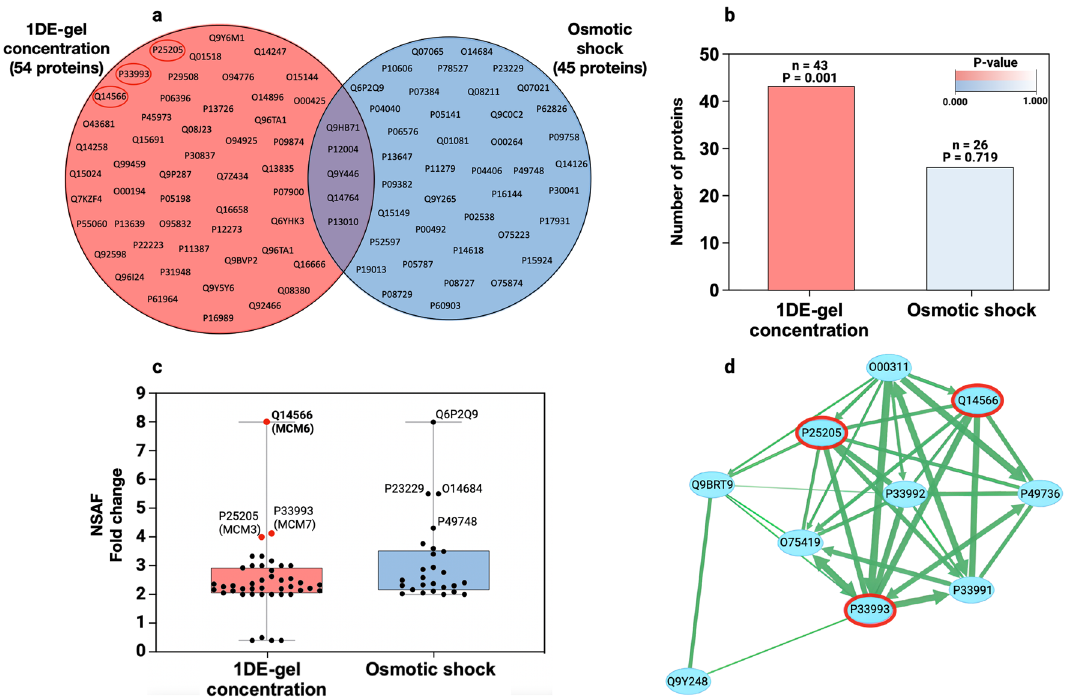
Figure 5. Comparative proteoinformatics pipeline. ( a ) Venn diagram illustrating the distribution of up- and downregulated (≥ 2 times) proteins associated with cellular proliferation disease (DOID:14566); ( b ) the number of skin cancer associated proteins (according to COSMIC database: https:// cancer. sanger. ac. uk/ cosmic, accessed on 21 June 2022); ( c ) NSAF fold change distribution of skin cancer associated proteins (COSMIC database); ( d ) Protein–protein interaction (PPI) network of double-strand break repair via break-induced replication pathway (GO:0,000,727). The skin cancer associated proteins (COSMIC database) identified with Protocol 1 (0.2% SDS solubilization + 1DE-gel concentration) are circled in red.